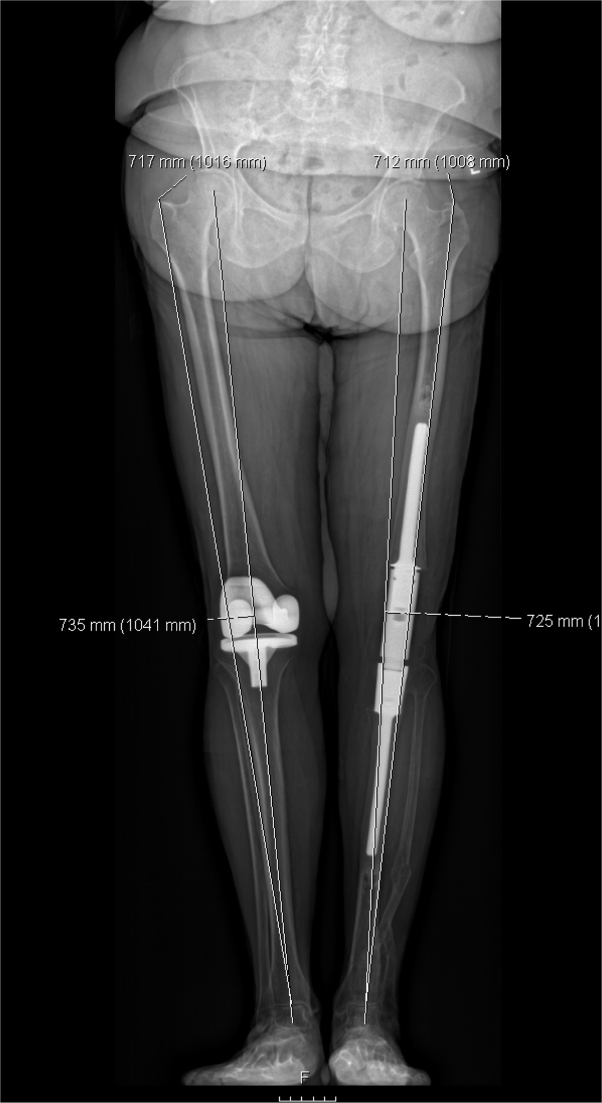
Coronal EOS imaging of same patient from the representative case in Figure 1 at 1 y postoperatively.